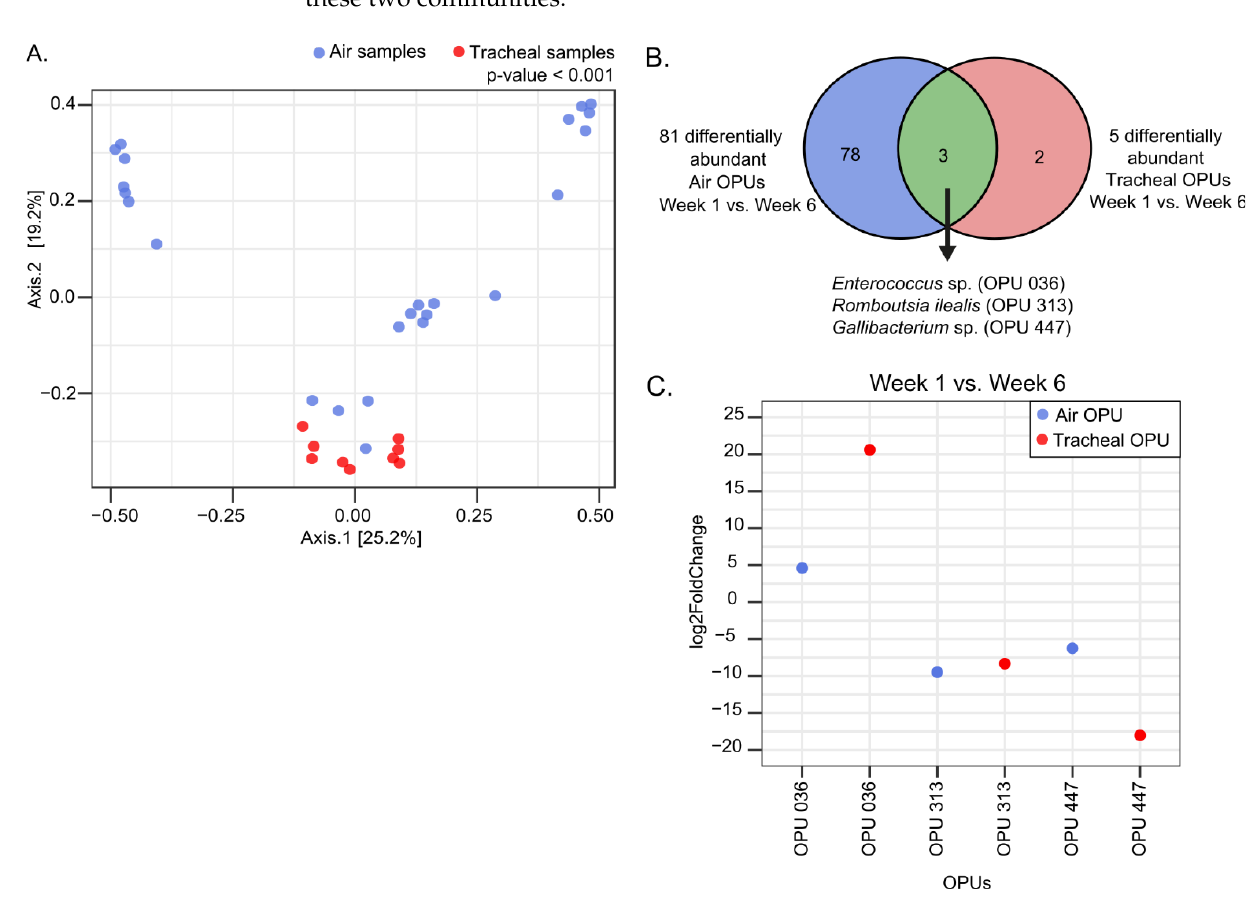
Figure 8. Beta-diversity and differential abundance analyses of environmental air and tracheal samples. ( A ) PCoA of environmental and tracheal samples using Bray–Curtis beta diversity measures. Statistics: PERMANOVA. ( B ) Venn diagram of OPUs analyzed in DESeq2 for air and tracheal samples. ( C ) DESeq2 analysis results indicating the Log2fold change of significant bacterial OPUs ( p -adjusted < 0.05) in environmental air and tracheal samples.